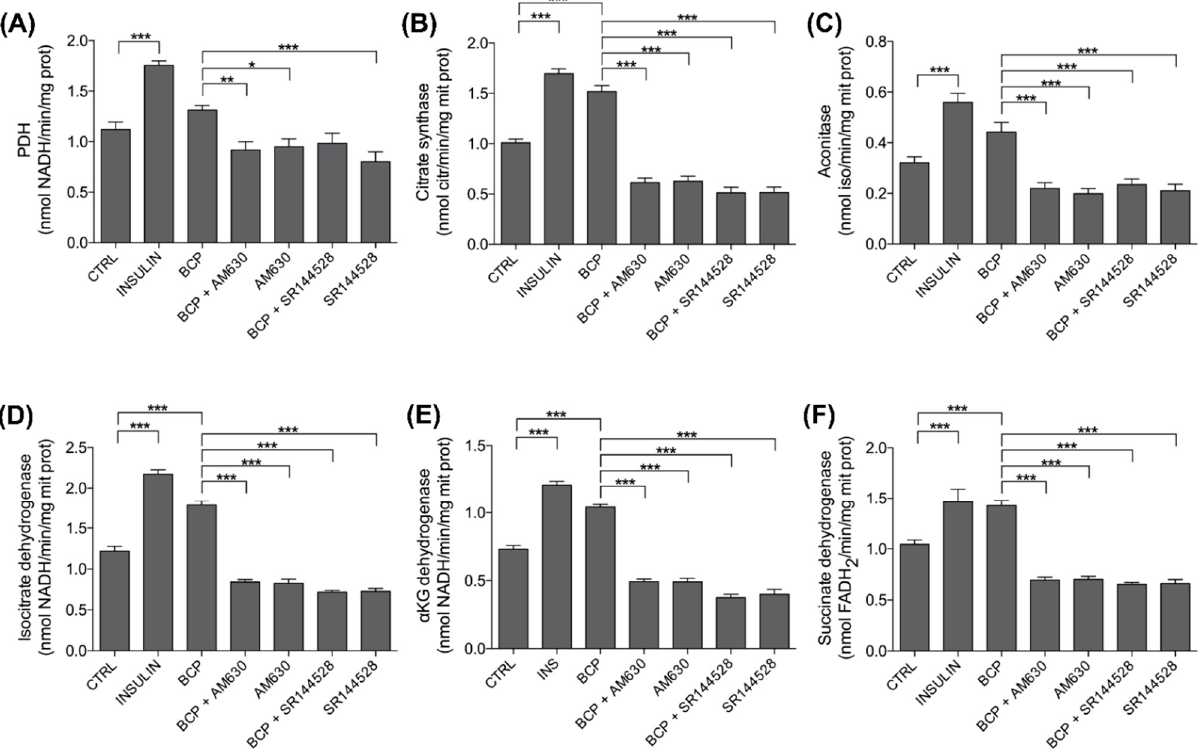
Figure 5. Effects of BCP on mitochondria metabolism. C2C12 cells were left untreated (CTRL) or treated with insulin (25 nM for 30 min; INS), BCP (10 nM for 30 min), AM630 (5 µ M for 2 h), or SR144528 (5 µ M for 2 h), alone or in combination with 10 nM BCP, added in the last 30 min. The enzymatic activities of ( A ) pyruvate dehydrogenase (PDH), ( B ) citrate synthase, ( C ) aconitase, ( D ) isocitrate dehydrogenase, ( E ) α -ketoglutarate ( α KG) dehydrogenase, and ( F ) succinate dehydrogenase were measured spectrophotometrically in mitochondrial extracts in triplicate. Data are expressed as means ± SEM (n = 3). * p < 0.1, ** p < 0.01, *** p < 0.001. Table 2. BCP effects on mitochondrial pathway.